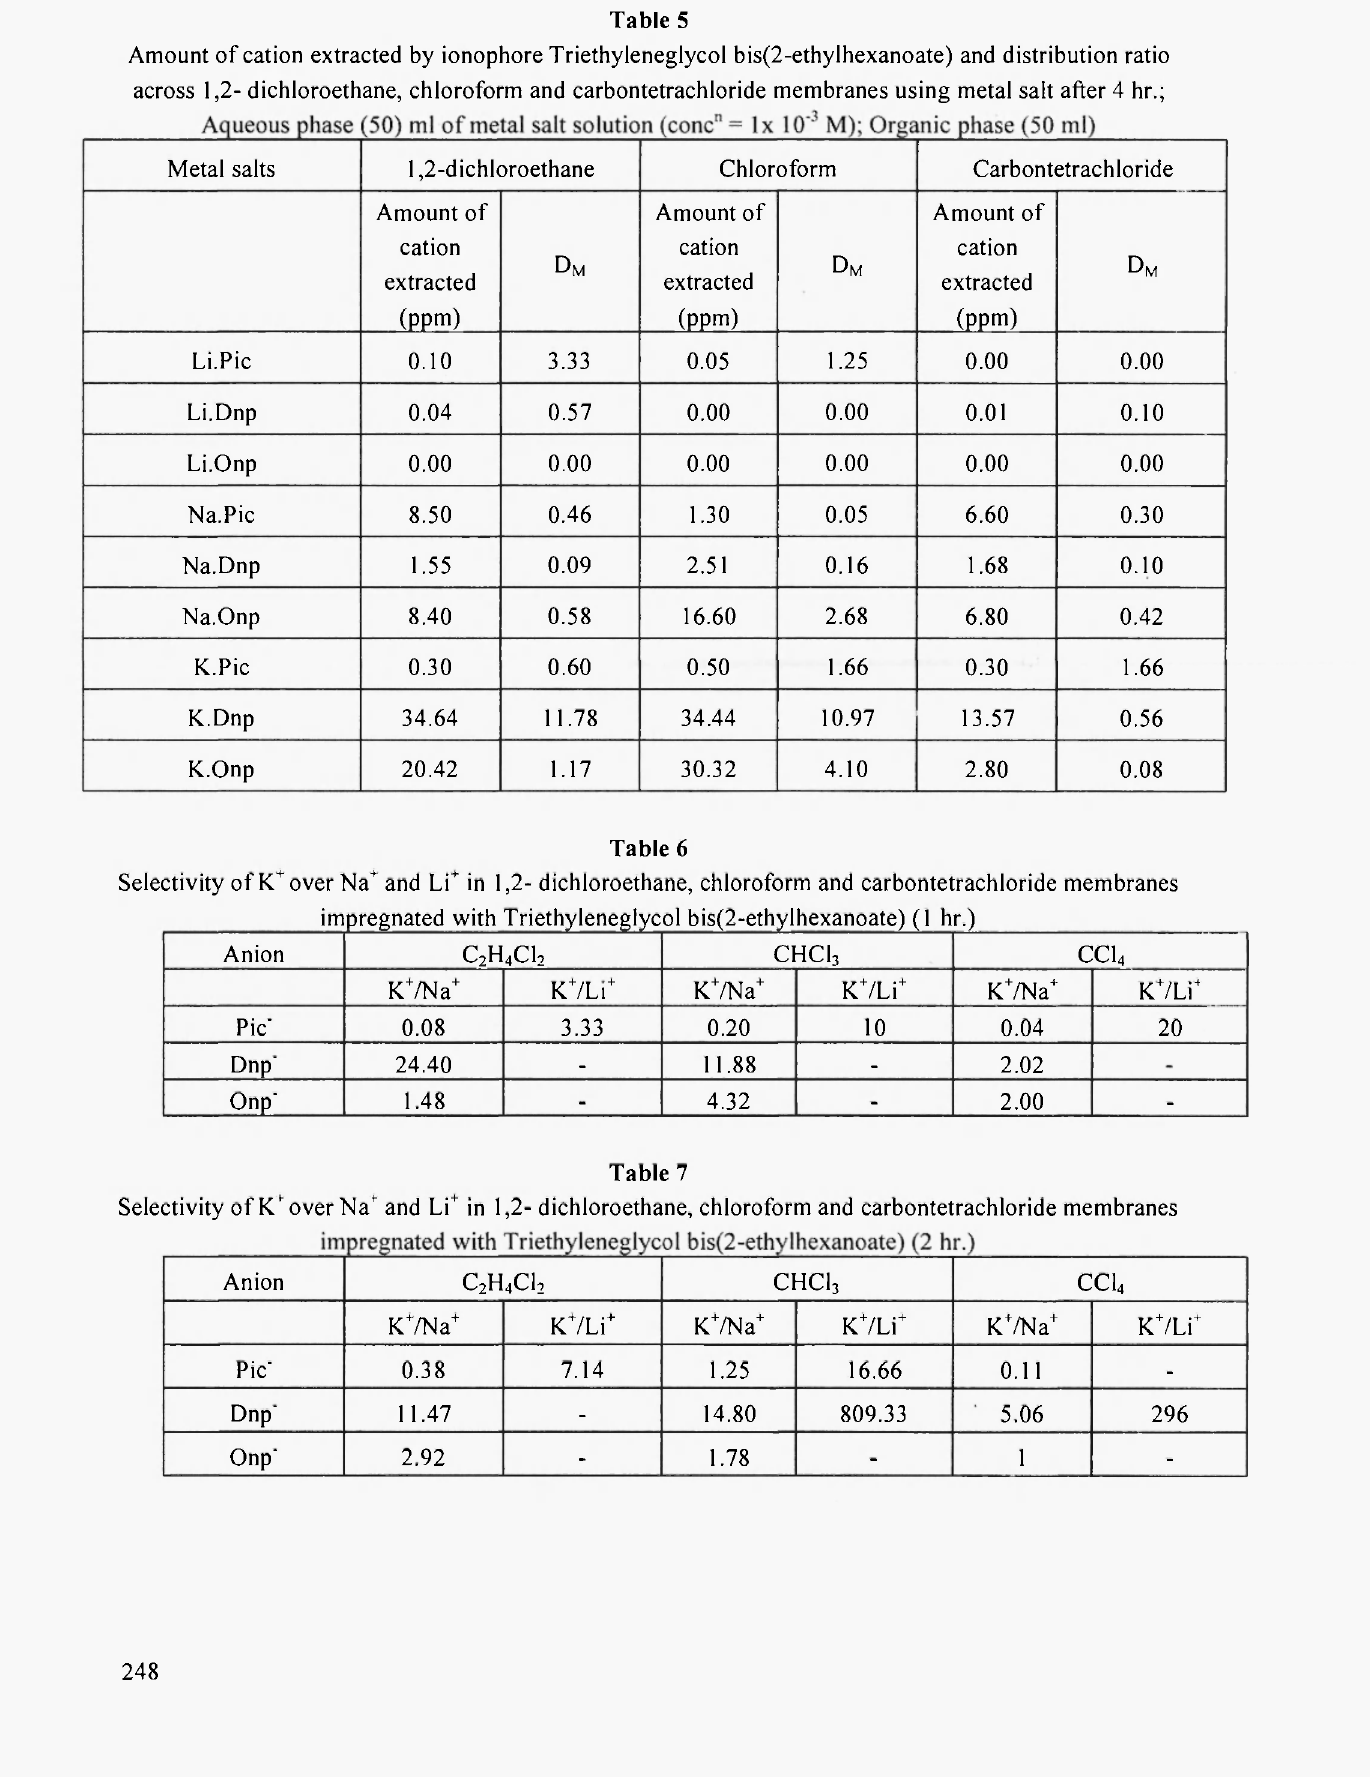
Amount of cation extracted by ionophore Triethyleneglycol bis(2-ethylhexanoate) and distribution ratio across 1,2- dichloroethane, chloroform and carbontetrachloride membranes using metal salt after 4 hr.;